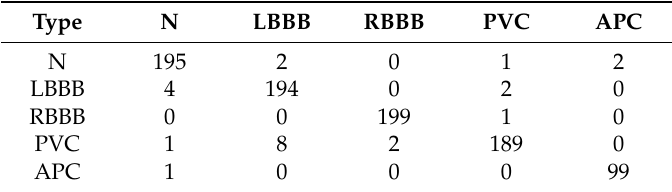
Table 4. The classification results based on electrocardiogram (ECG) acquisition experiment